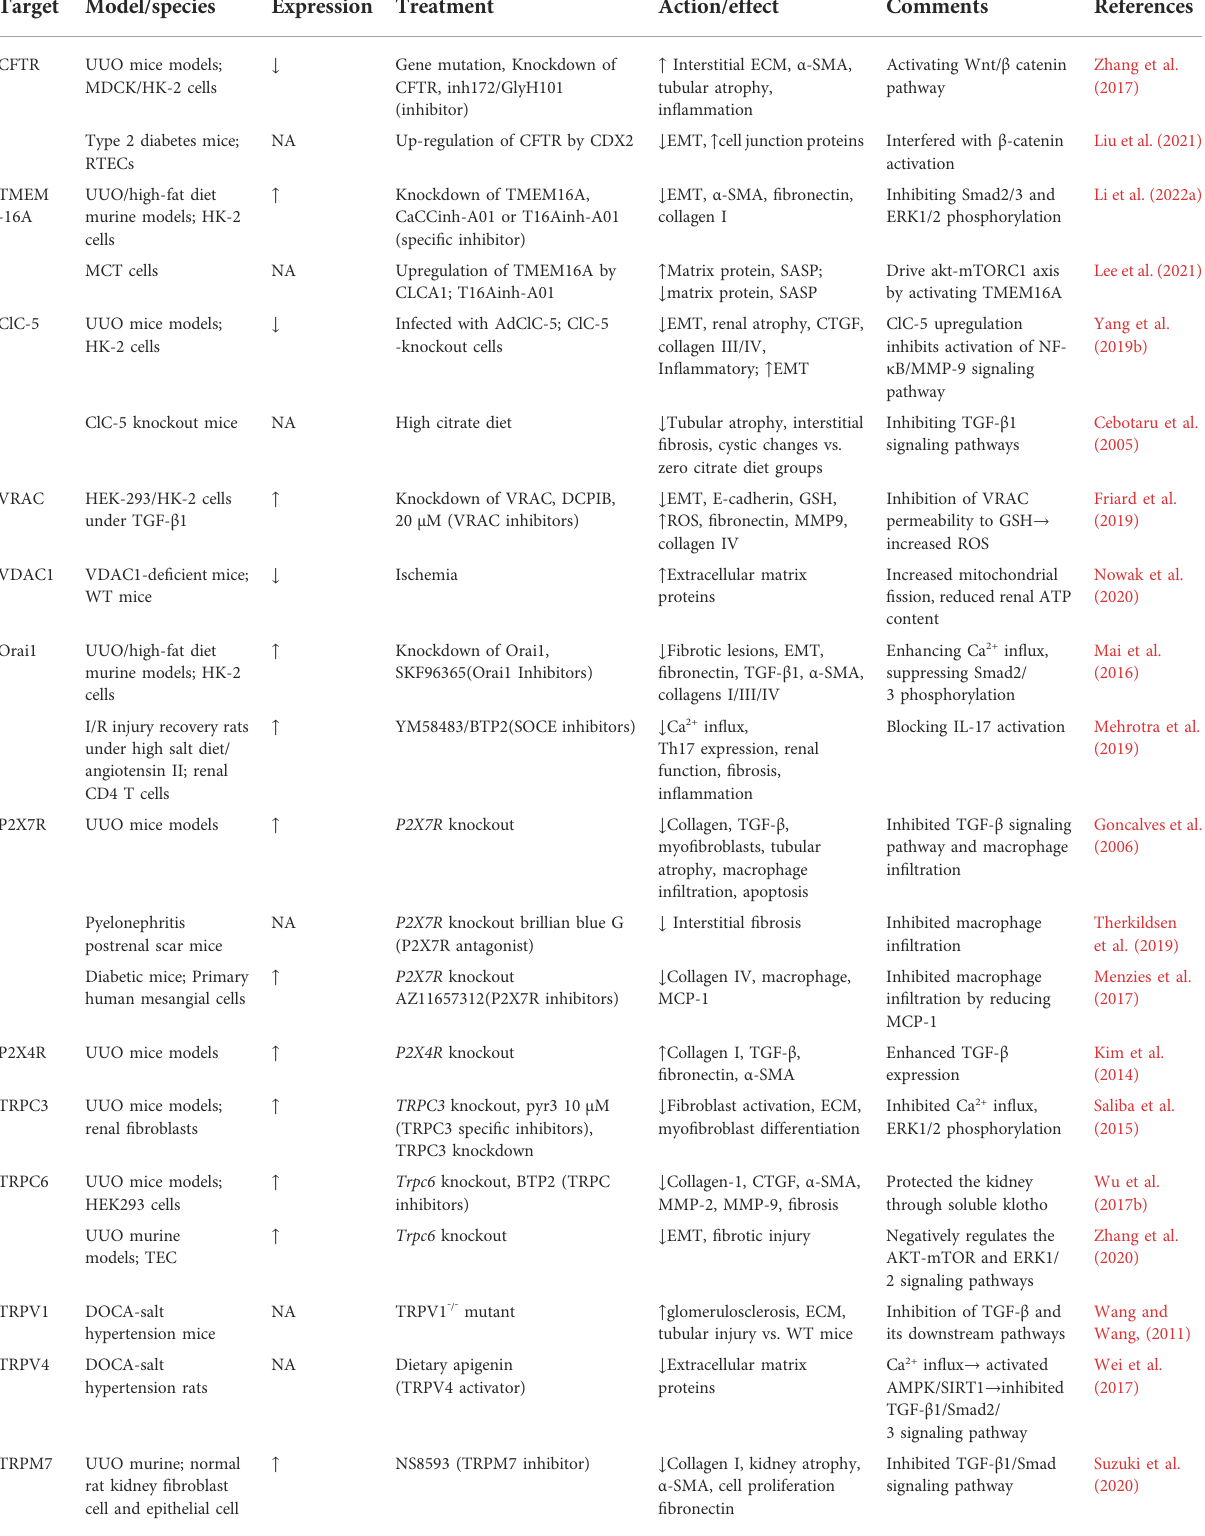
TABLE 1 The expression and function of various ion channels for renal fi